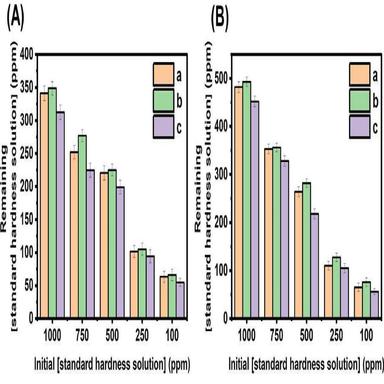
Hardness removal under (A) dynamic and (B) static conditions for (a) ACC (b) Cu-ACC and (c) 90% of ACC & 10% of Cu-ACC mixture.